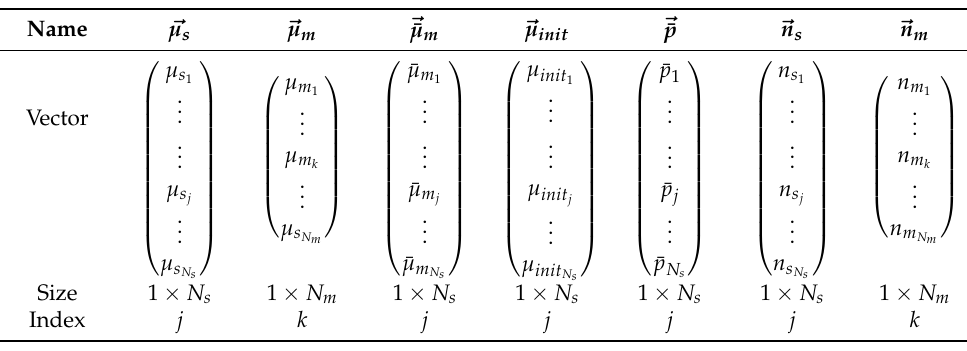
Table 4. Representation of all vectors used in the implementation in A BAQUS . Line 1 contains the name of the vector, line 2 marks the entries of the corresponding vector. Line 3 summarizes the size of the vector and line 4 indicates the run index, which is used to increment the entries of the vectors.